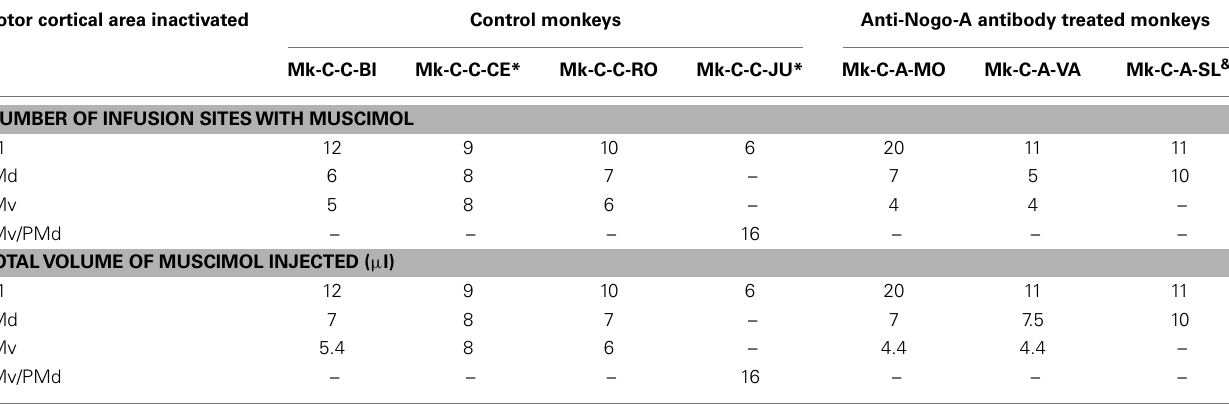
Table 3 | Survey of the monkeys involved in the reversible inactivation experiments, with indication of the number of sites infused with muscimol for each monkey and each daily session (corresponding to the inactivation of a given motor cortical area). Motor cortical area